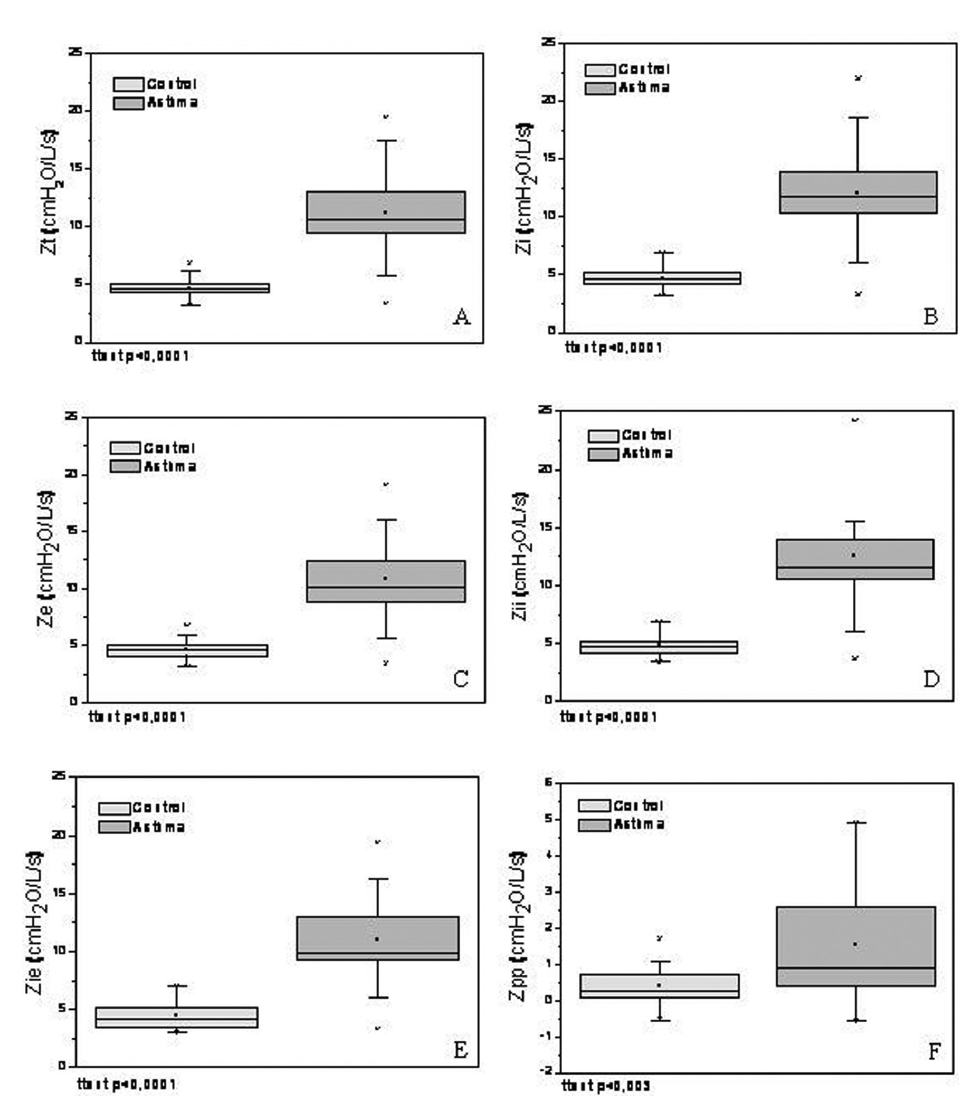
Figure 2 - Comparison among the total impedance (Zt, figure A), mean impedance during the inspiratory (Zi, B) and expiratory (Ze, C) phases, impedance at the beginning of inspiration (Zii, D) and of expiration (Zie, E), and peak-to-peak variation of the impedance (Zpp, F) in the studied groups. The top and bottom of the box plot represent the 25 th - to 75 th -percentile values, while the circle represents the mean value and the bar across the box the median. The whiskers outside the box represent the 5 th - to 95 th -percentile values. Data presented a statistically normal